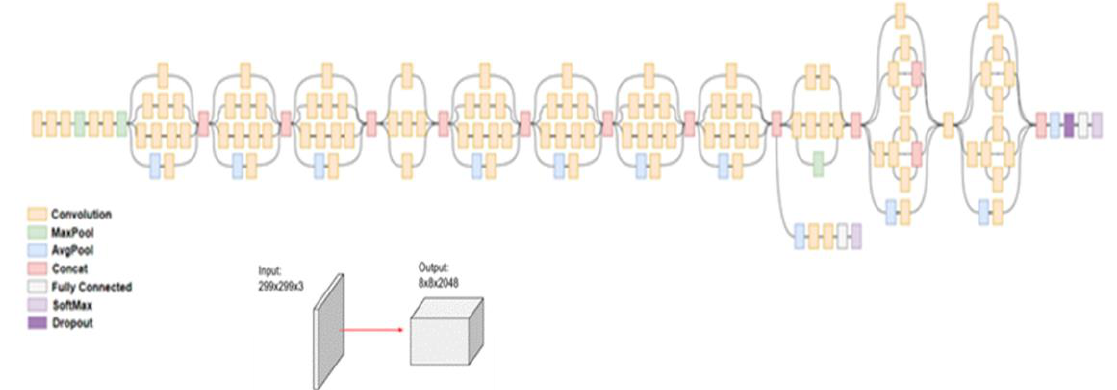
Figure 4. Inception v3 architecture and working flow.